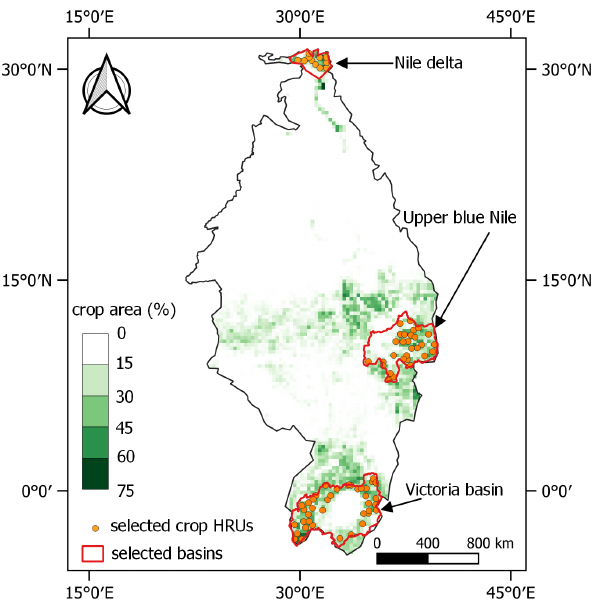
Figure 3. Crop area percentage and selected basins for LAI evalua-